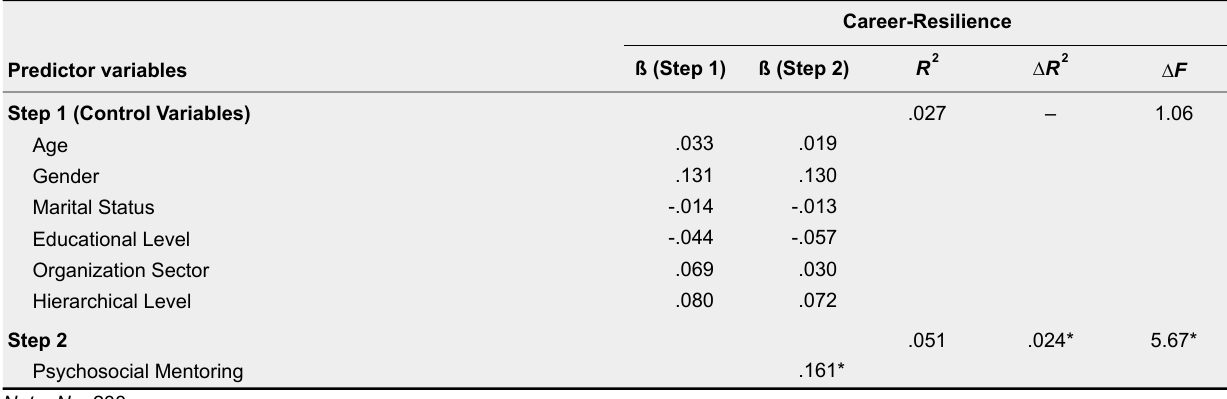
Hierarchical Multiple Regression Analysis: The Direct Effect of Psychosocial Mentoring on Career Resilience